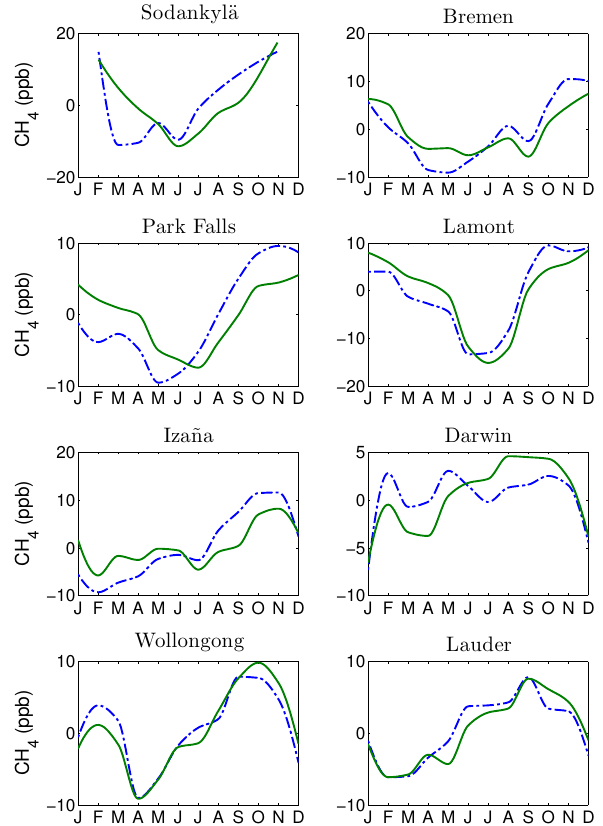
Figure 5. De-trended seasonal cycles of CH 4 for total (blue, dashed) and tropospheric (green, solid) columns averaged over all years.